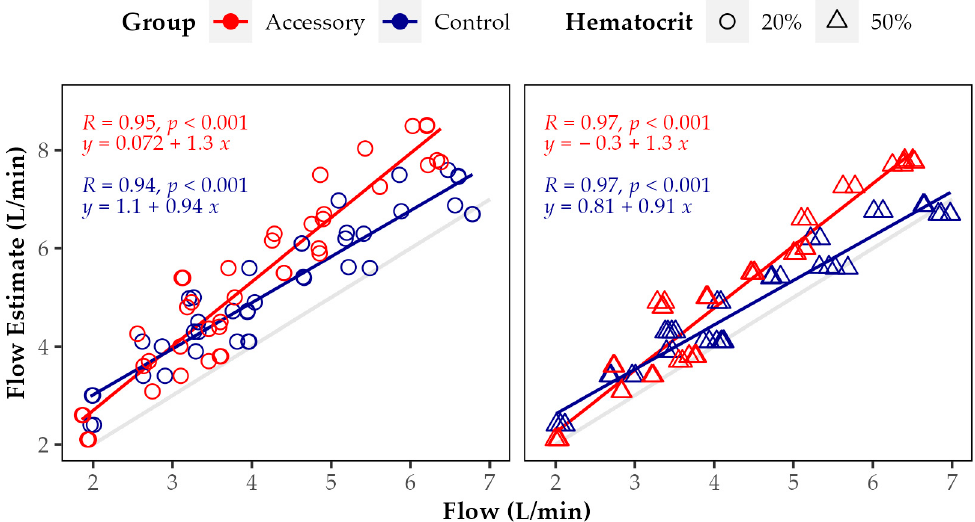
Figure 6. Correlation and linear regression between measured flow and HM3 flow estimates at 20 and 50% preset hematocrit in Accessory and Control groups throughout all rotational speeds and resistance levels. The gray line represents the reference line with measured and estimated flow being equal. Points and regression lines above this reference line indicate flow overestimation by the al- gorithm applied to estimate the pump fl ow.